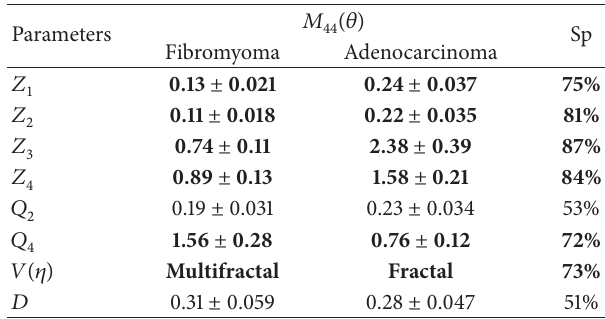
Table 2: Parameters of the statistic, correlation, and self-similar structure of 𝑀 44 (𝜃) of circular birefringence of polycrystalline uterine tissue